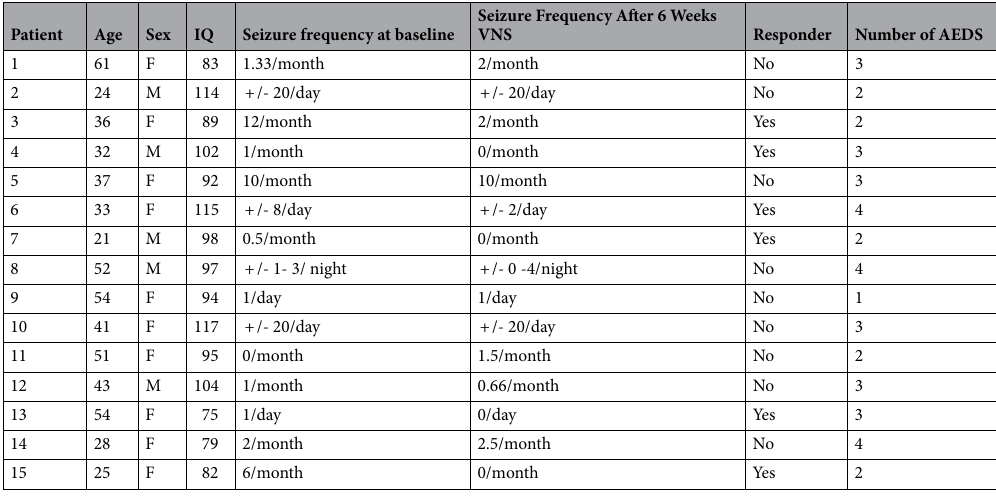
Table 1. Overview of demographic and clinical characteristics. AED, anti-epileptic drug; F, female; M,